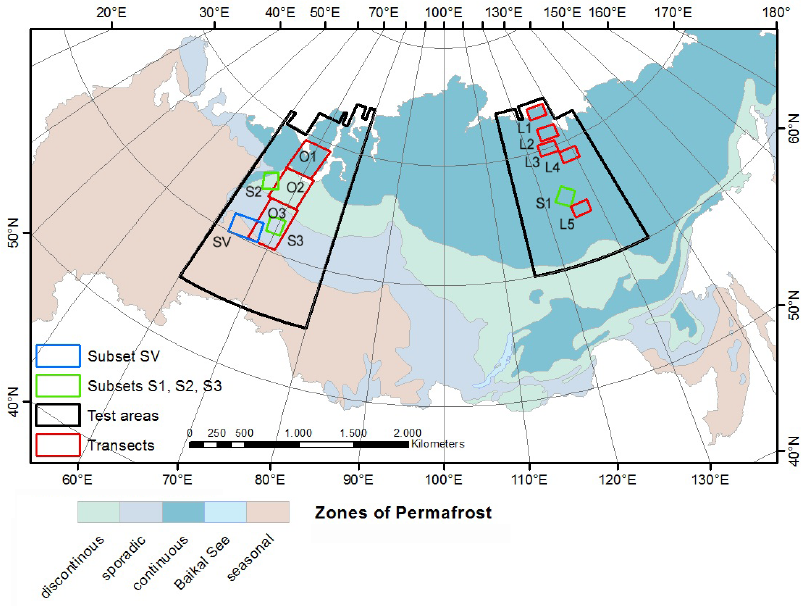
Figure 2. Extent of permafrost of the West Siberian Lowlands (Dataset IIASA [26]). The test areas of Ob basin and Delta and Lena basin and Delta are outlined in black. The extents of subsets and transects used for validation are shown in red, green and blue (compare Chapter 4: Assessment).